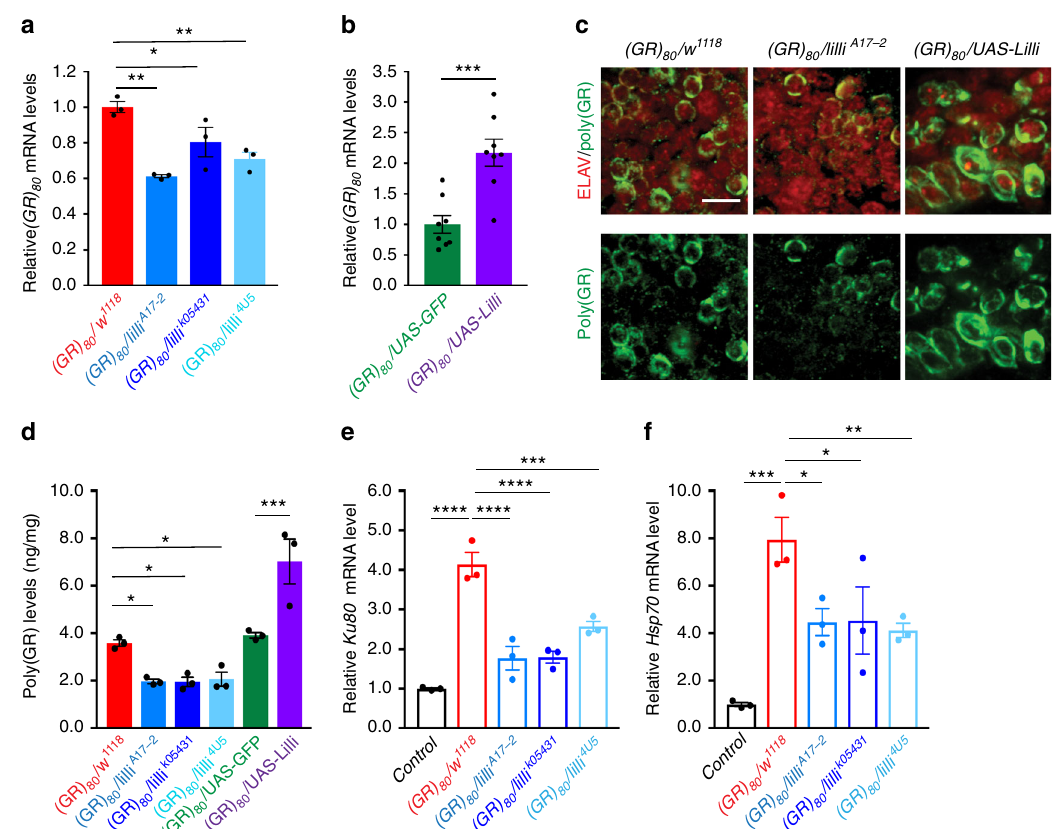
Fig. 4 Partial loss of Lilli suppresses poly(GR) toxicity. a , b QPCR analysis of (GR) 80 mRNA level in 2-week-old fl y heads. n = 3 independent crosses in a and n = 8 independent crosses in b . Values are mean ± s.e.m. * p < 0.05; ** p < 0.01, *** p < 0.001 (one-way ANOVA, Dunnett ’ s test ( a ), Welch ’ s t test ( b )). c Immunostaining of 2-week-old fl y brains for ELAV (red) and poly(GR) (green). Scale bar: 5 μ m. d Poly(GR) levels in lysates of heads from 2-week-old fl ies were determined by MSD immunoassay ( n = 3 independent crosses). Values are mean ± s.e.m. * p < 0.05, *** p < 0.0001 (one-way ANOVA, Dunnett ’ s test). The expression levels of Ku80 ( e ) and Hsp70 ( f ) mRNAs in 2-week-old fl y heads were assayed by qPCR. Values are mean ± s.e.m. n = 3 independent crosses. * p < 0.05; ** p < 0.01, *** p < 0.001, **** p < 0.0001 (one-way ANOVA, Dunnett ’ s test). Source data are provided as a Source Data fi